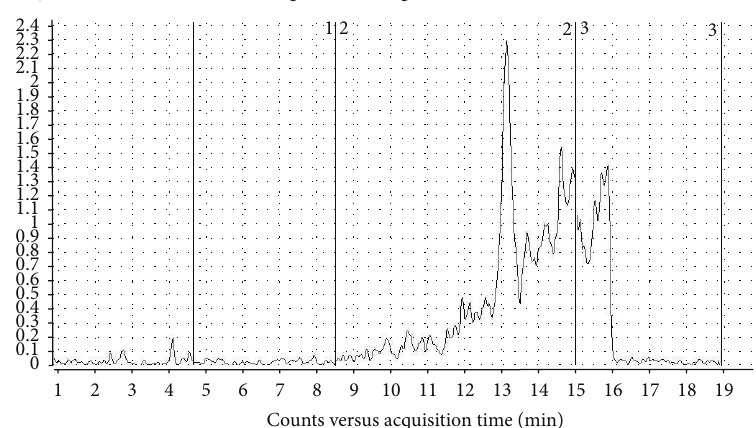
Figure 2: MS spectrum of PTX2 molecule and confirmation of exact formula generated from compound mass spectrum.